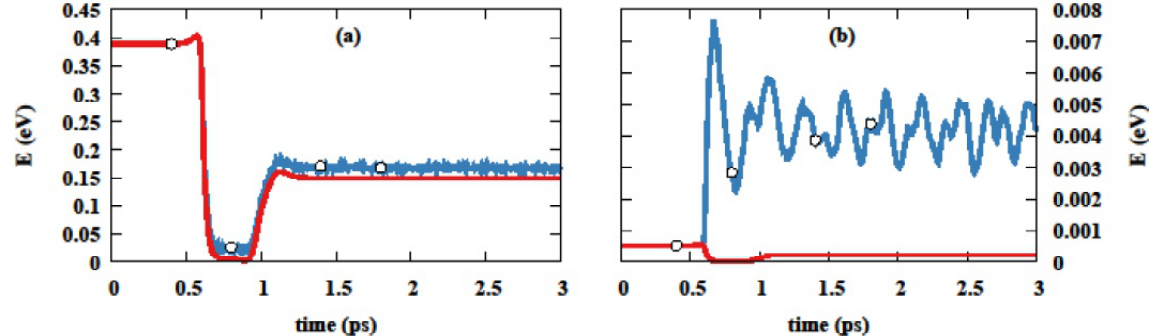
Fig. 3. Kinetic energy per atom (blue curves) and kinetic energy of the center of mass per atom (red curves) for (a) C and (b) C colliding at the initial velocity of V 20 540 the snapshots from Fig.